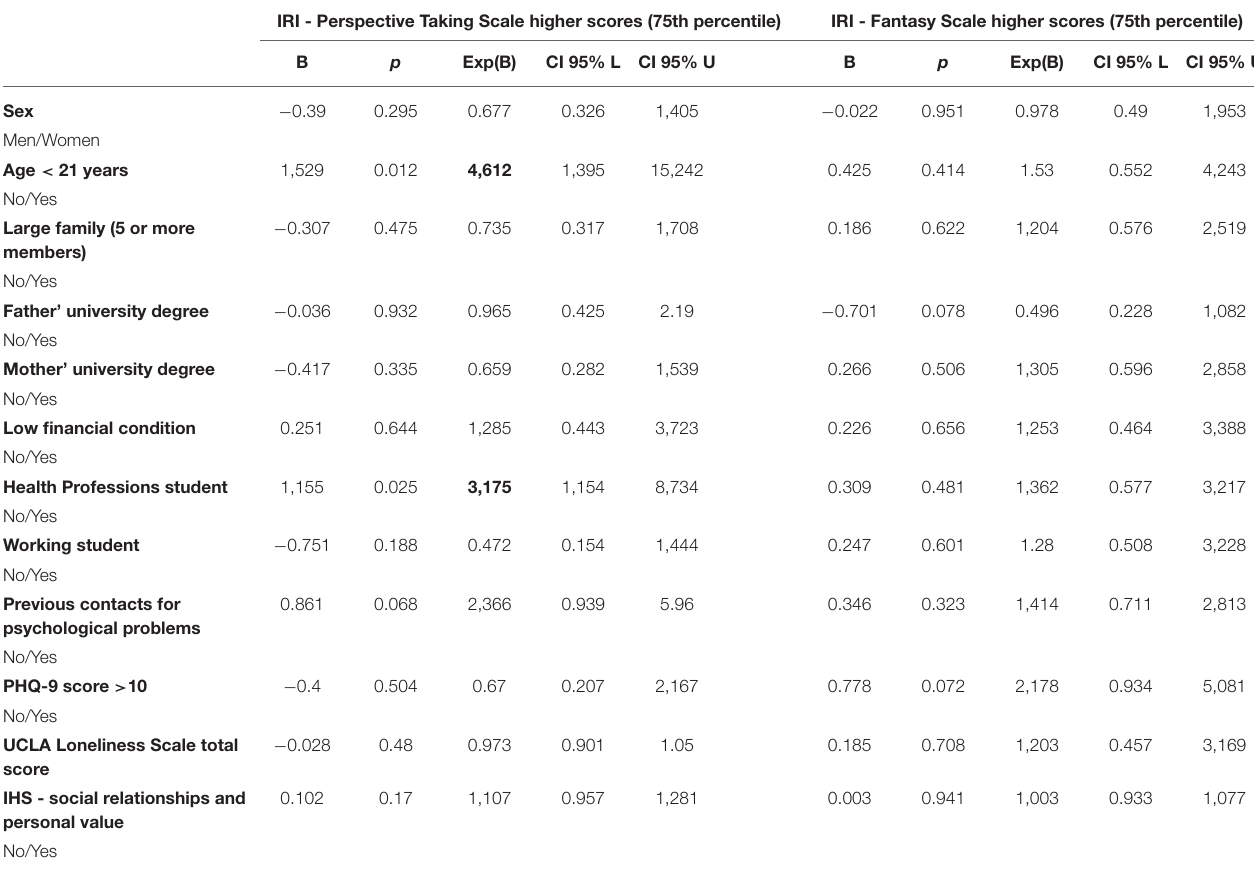
TABLE 5 | Logistic regression analysis for predicting the cognitive dimensions of empathy as measured by Interpersonal Reactivity Index (IRI). IRI - Perspective Taking Scale higher scores (75th